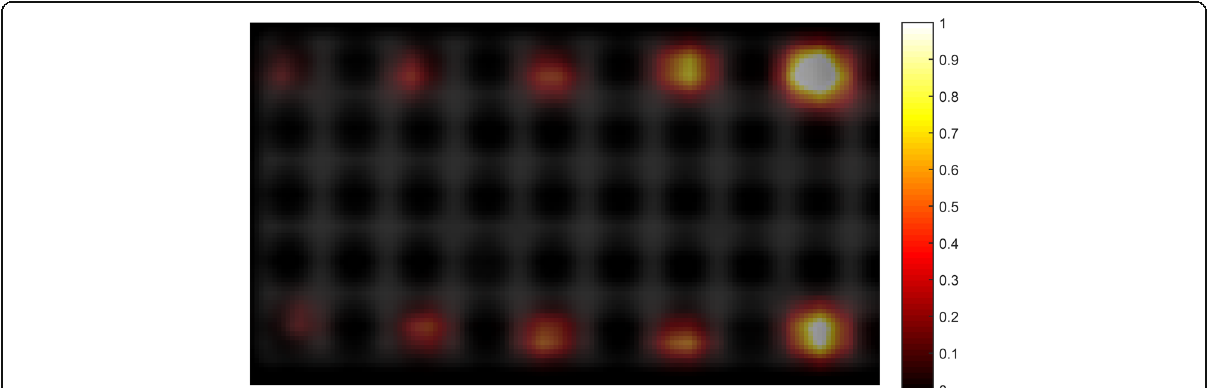
Fig. 6 PET/CT image of 10 different Eppendorf tubes, all containing 1 × 10 5 LNCaP cells in 1 ml media and incubated at different concentrations of Ga68-PSMA-11. First row of tubes from left to right, 193, 338, 544, 780, and 996 nM radioligand concentration, respectively (replicated in the second